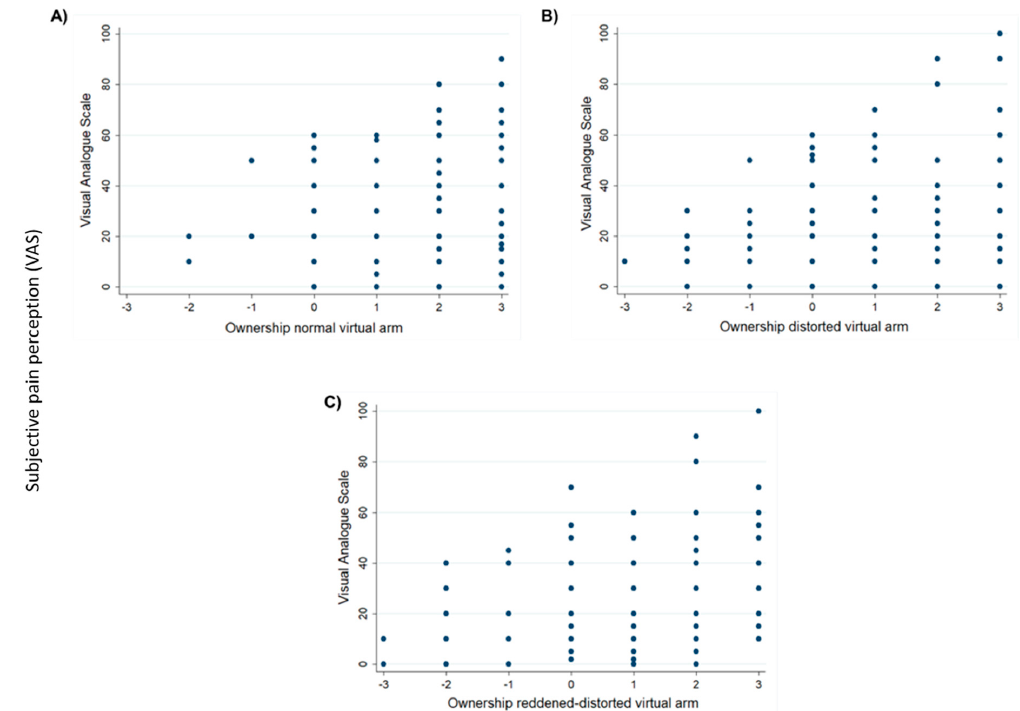
Figure 3. Pain ratings increase with the distortion of the embodied virtual arm. The relationship between pain ratings and ownership levels under the ( A ) normal virtual arm condition (no relationship); ( B ) the distorted virtual arm condition; and ( C ) the reddened-distorted virtual arm condition.